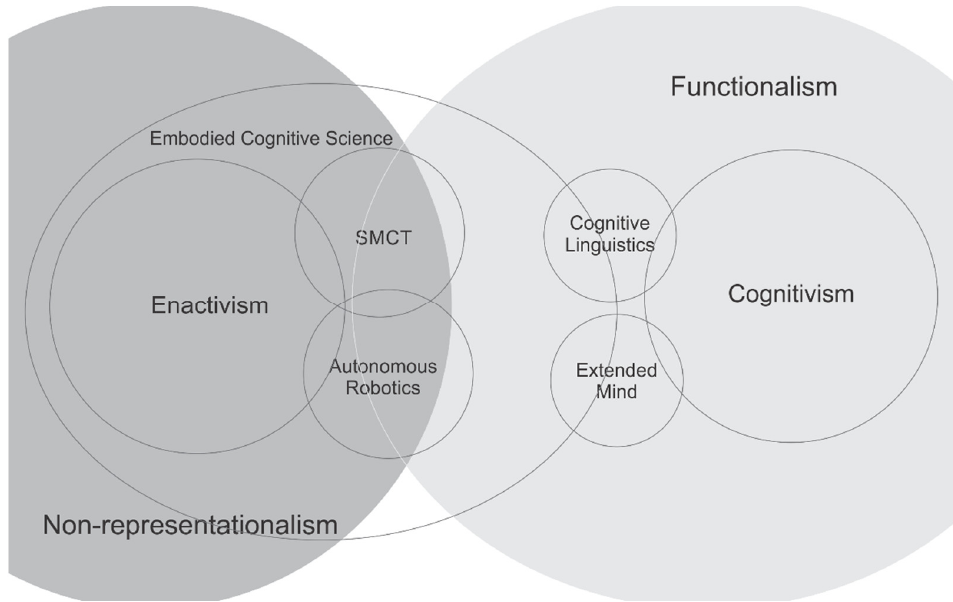
Figure 1. Schematic figure of the state of contemporary cognitive sciences, based on [13].